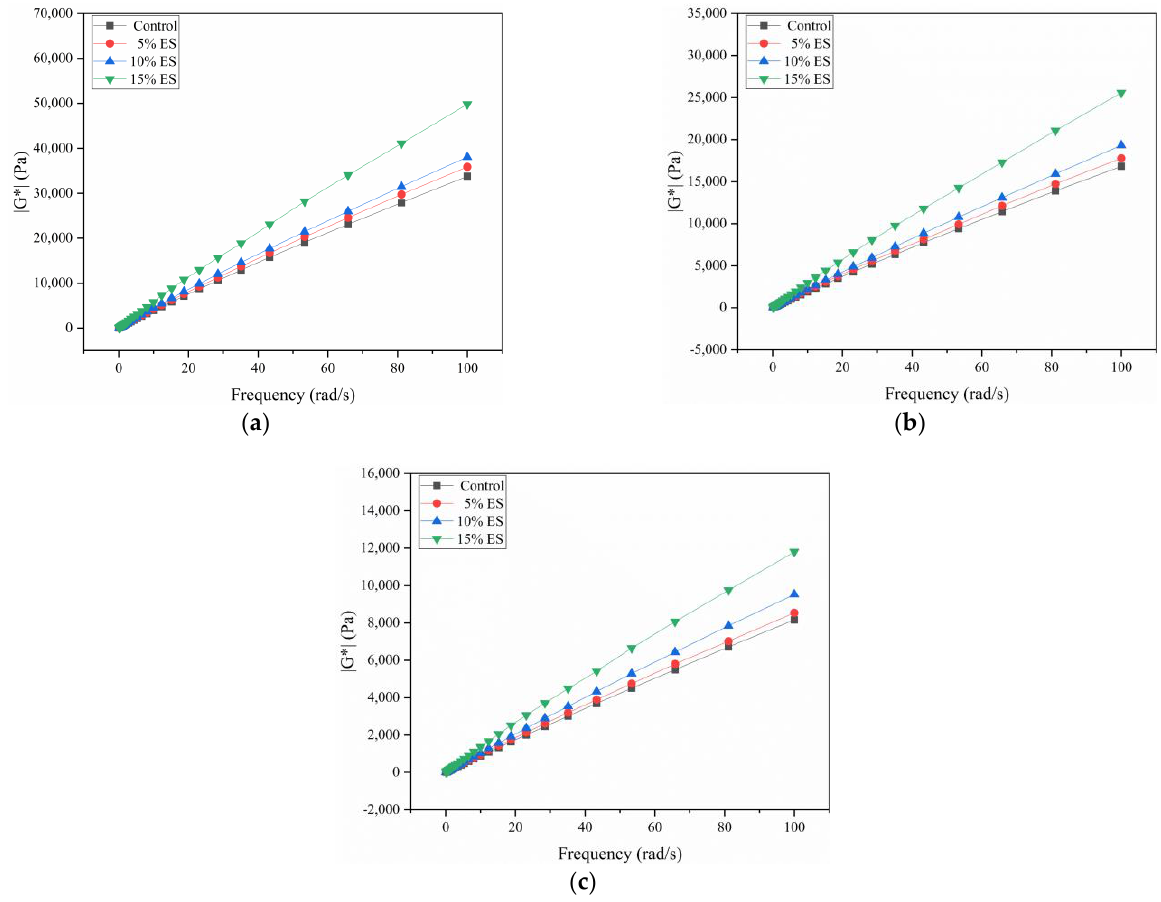
Figure 8. Frequency sweep results of 5, 10, and 15% eggshell powder bitumen: ( a ) 58 °C, ( b ) 64 °C, ( c ) 70 °C.